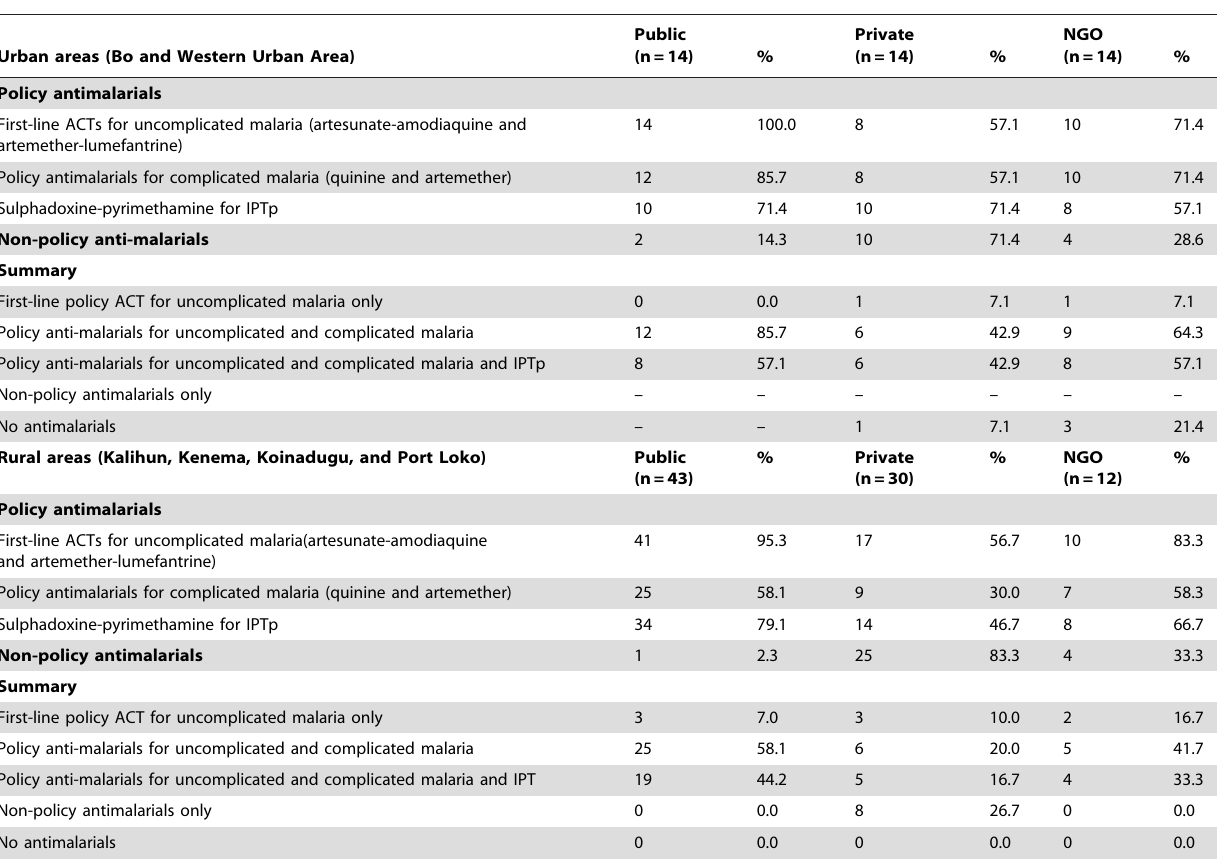
Table 2. Availability of antimalarials by urban vs. rural areas and Sector Type.